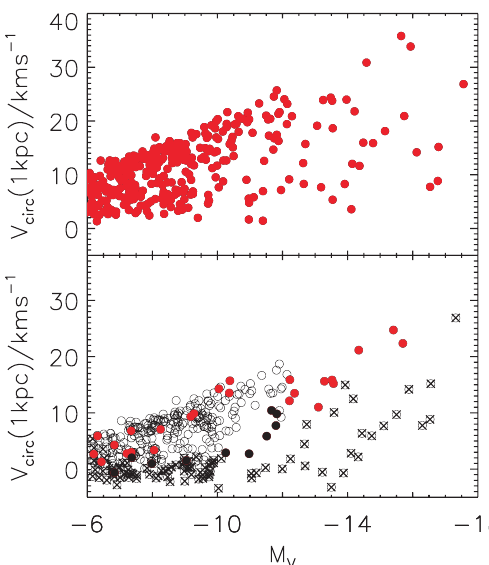
Figure 18. Baryonic effects on VL2 simulation subhaloes, seen through their changes in v 1 kpc vs. M V . VL2 satellites are labelled, as in [74], in the top panel, by their velocities vs. M V at z = 0. The same, after baryonic corrections, are presented in the bottom panel. Satellites stripped of their stars from losing enough mass are represented by filled black circles: at infall, their actual luminosities are much fainter and indicated luminosities are only upper limits. Satellites actually observable at z = 0 appear as filled red circles. Empty circles mark dark subhaloes, those with an x being most probably tidally destroyed (figure reproduced from [403]).